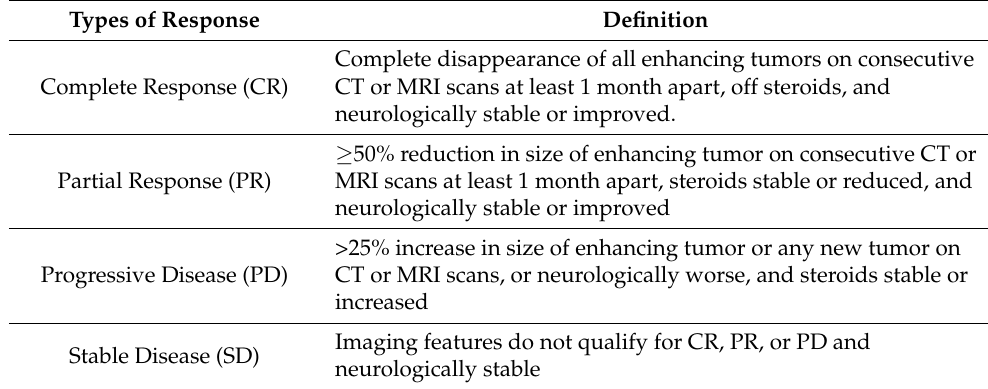
Table 5. MacDonald criteria for assessment of brain tumor treatment response